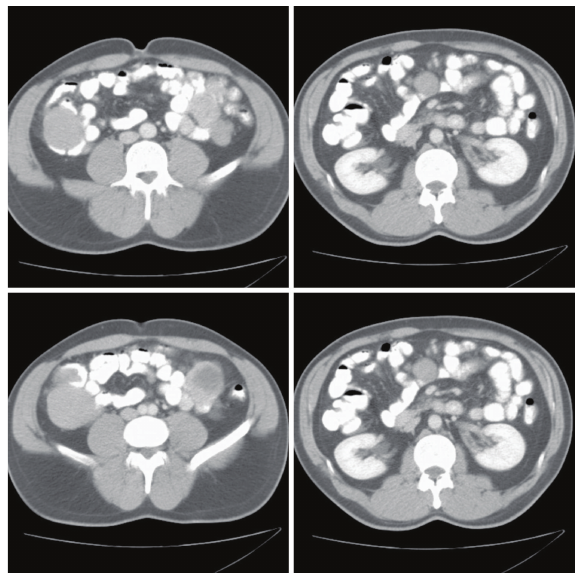
Figure 2: Computed tomography images of the